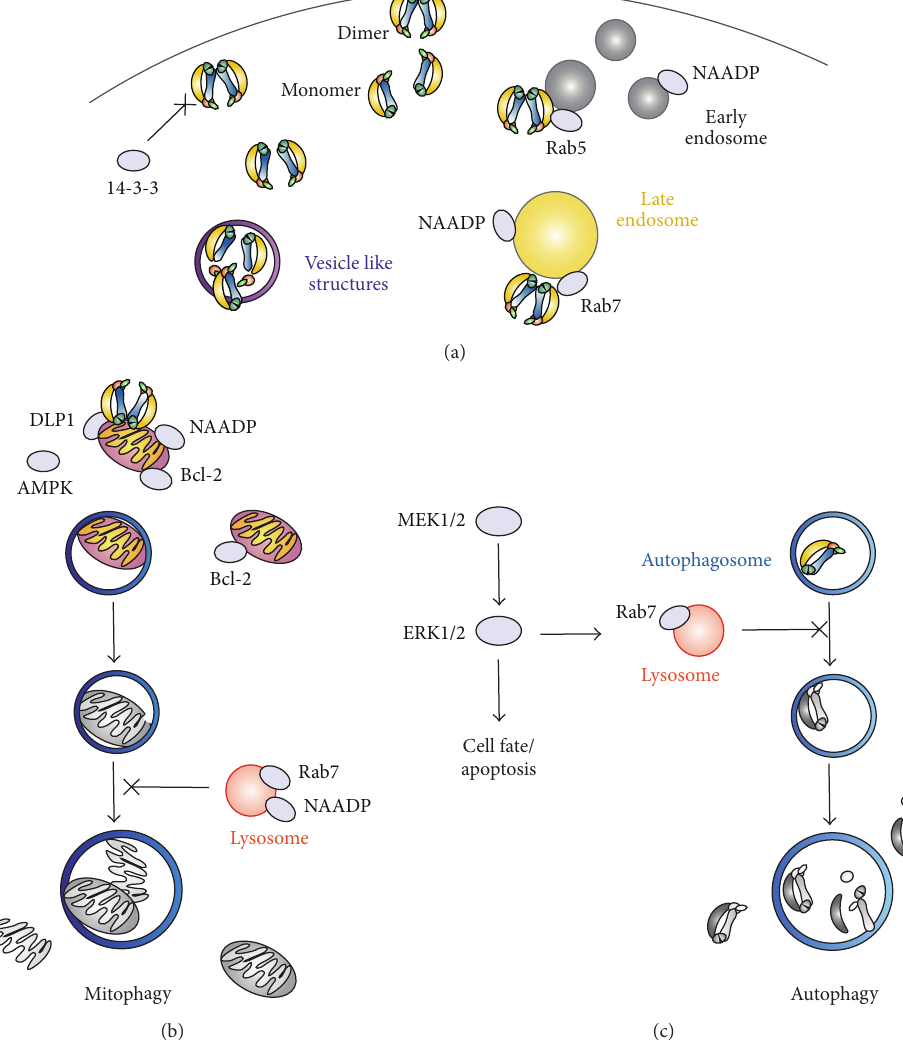
Figure 3: Proposed pathways regulating LRRK2-mediated mitochondrial homeostasis and